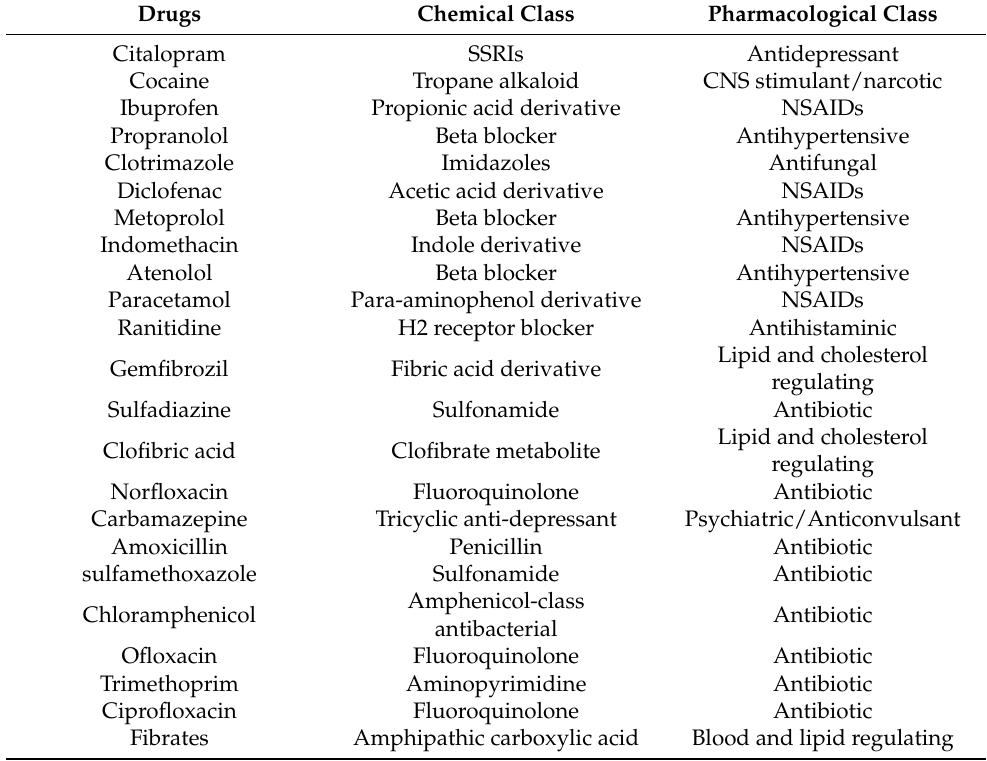
Table 1. Prevalent drugs in